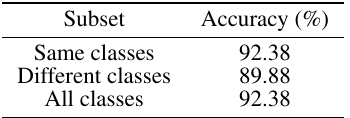
Table 6. Fine-tuning accuracies on UCM when different subsets of MLRSNet are used for